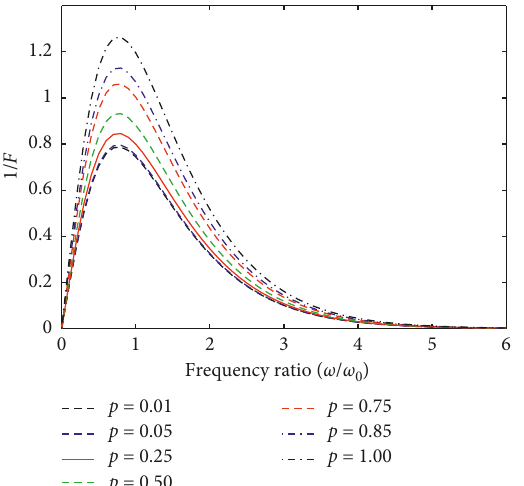
Figure 19: Chaotic threshold curve with different h values ( m � 1, k 1 � 1, c 1 � 0.5, k 3 � 1, and p � 0 .